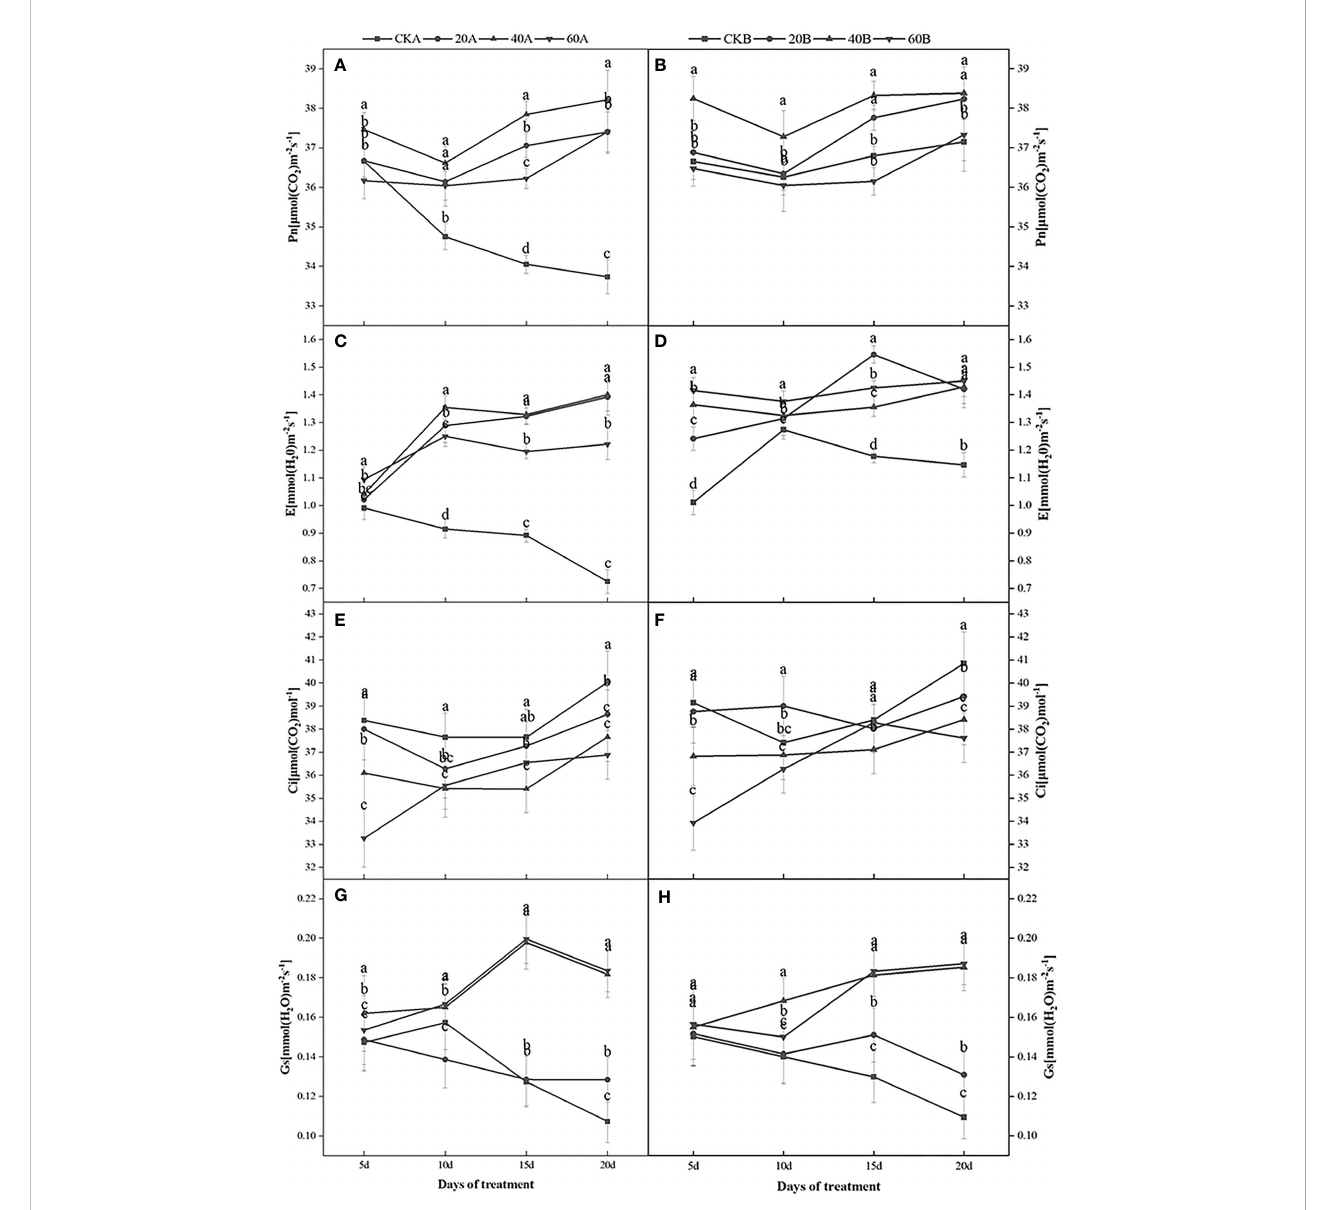
FIGURE 2 Effects of GA 3 on net photosynthetic rate (Pn), transpiration rate (Tr), intercellular CO 2 concentration, and stomatal conductance (Gs) in different light- sensitive inbred maize lines under low light stress. (A, B) show the Pn values; (C, D) show the Tr values; (E, F) show the intercellular carbon dioxide concentrations; and (G, H) show the Gs values. In the fi gure panels, 20A, 40A, and 60A denote SN98A sprayed with 20 mg L – 1 ,40 mg L – 1 , and 60 mg L – 1 GA 3 , respectively, and 20B, 40B, and 60B denote SN98B sprayed with 20 mg L – 1 ,40 mg L – 1 ,and 60 mg L – 1 GA 3 .CKA denotes the SN98A control group sprayed with water and CKB denotes the SN98B control group sprayed with water. Values are expressed as mean ± SD of three replicates. Lower-case letters indicate the mean difference of different treatments in the same period, which is statistically signi fi cant